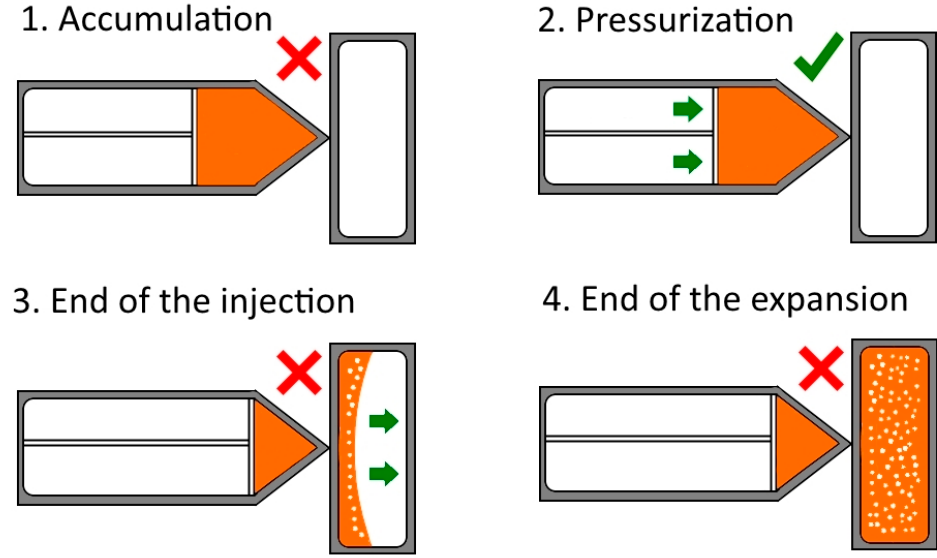
Figure 1. Schematic stages of the low-pressure injection molding process. The green tick ( red cross ) indicates the aperture ( closure ) of the valve between the nozzle and the mold.